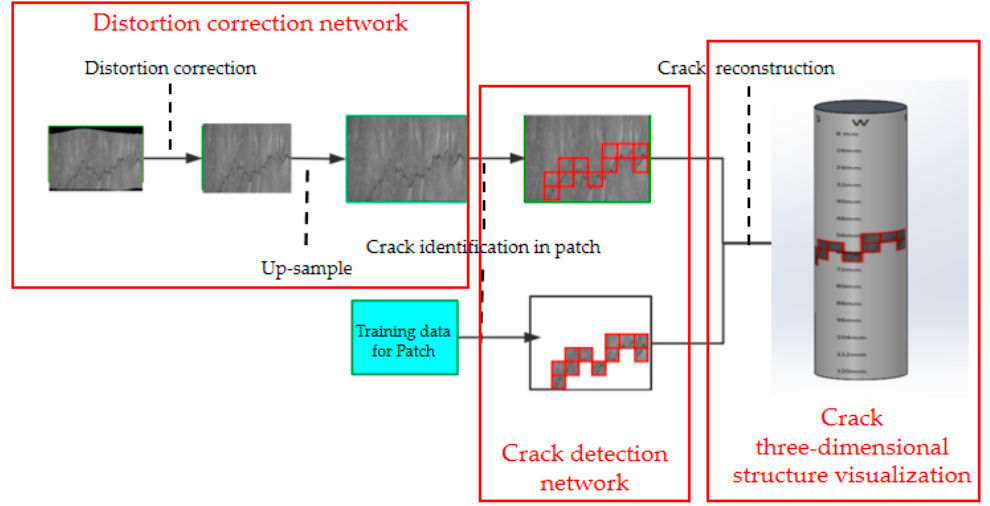
Figure 4. Flowchart of the entire method.